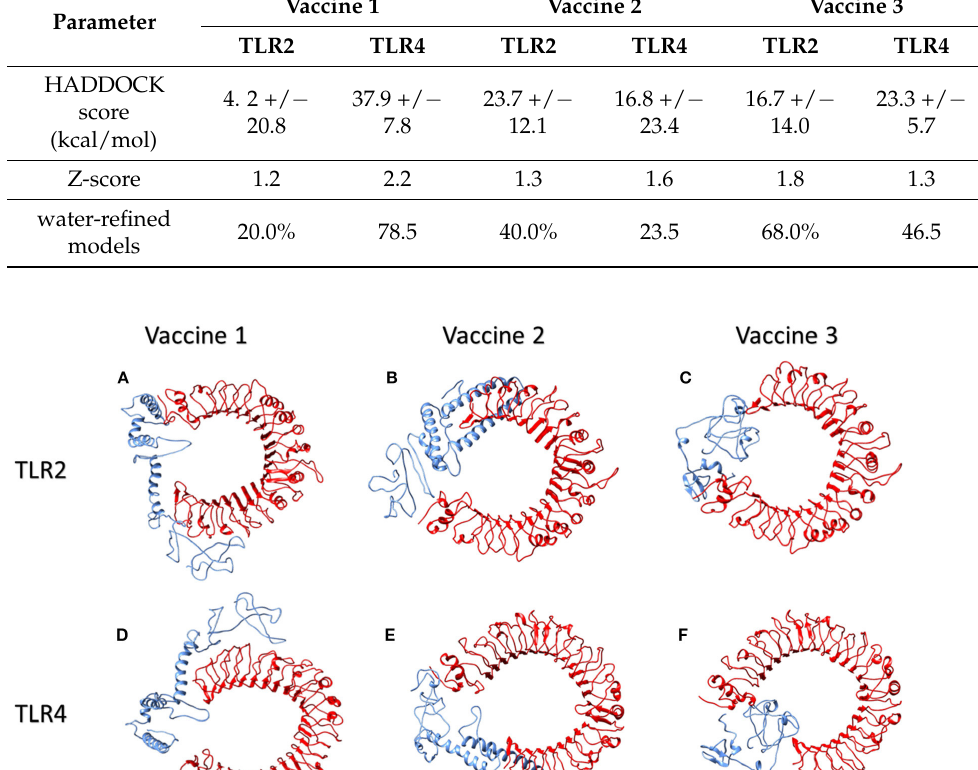
Figure 13. The interactions of human TLR2 and TLR4 proteins (red) with the candidate multi-epitopic COVID-19 vaccines ( 1-3 ) (blue) representing in subfigures ( A-F ), respectively [122]. Permission and copyright © from www.frontiersin.org (accessed on 20 October 2021).